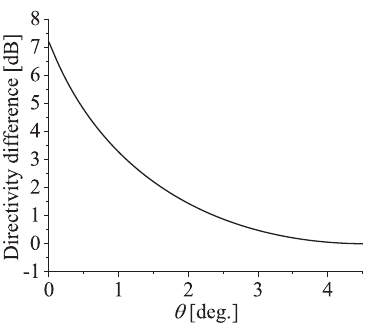
Fig. 2. Directivity difference between 1.5 and 2GHz.